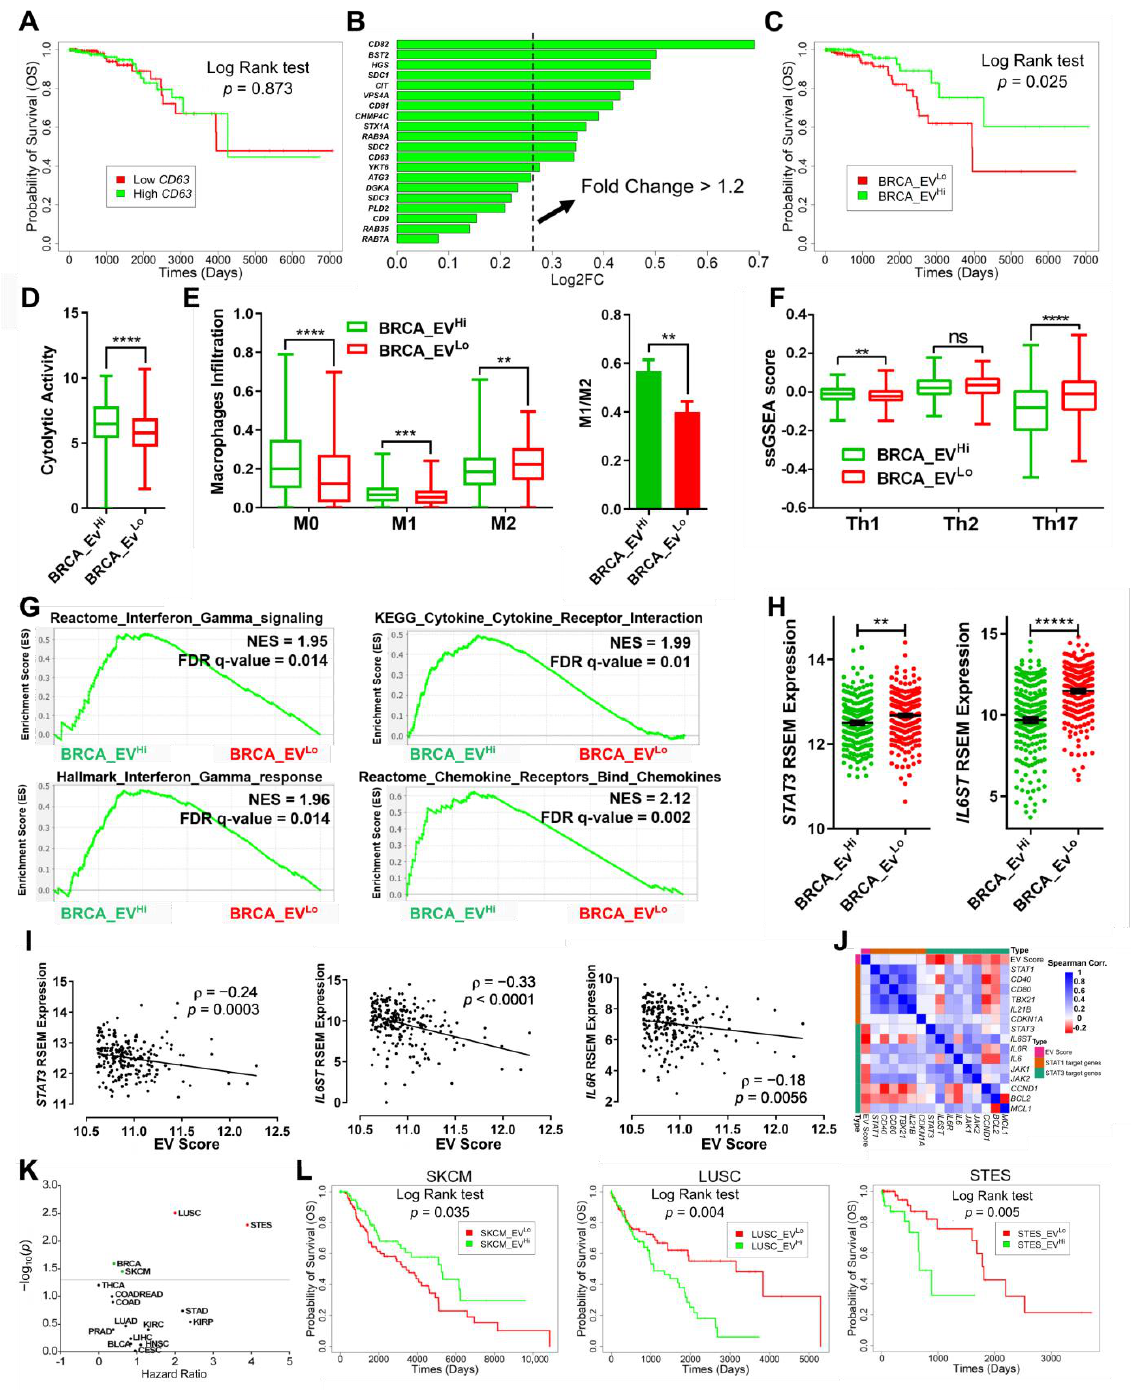
Figure 5. Increased EV secretion is correlated with better survival in non-metastatic breast cancer patients. ( A ) The overall survival of non-metastatic breast cancer patients (N0 and M0 in TNM staging system) divided by the median of CD63 expression. ( B ) Enrichment of the genes associated with CD81 + CD63 + EVs secretion in the BRCA_EV Hi patients. The 13 genes with fold change > 1.2 were selected as the CD81 + CD63 + EV gene signature. ( C ) Differences in the survival of non- metastatic breast cancer patients stratified by the median expression of CD81 + CD63 + EV gene signature. ( D ) Cytolytic activity score of non-metastatic breast tumors comparing the BRCA_EV Hi and BRCA_EV Lo patients (mean ± SEM). **** p < 0.01. ( E ) Macrophage infiltration scores and ratio of M1/M2 macrophages for the BRCA_EV Hi and BRCA_EV Lo tumors deter- mined by CIBERSORTx (mean ± SEM). ** p < 0.01, *** p < 0.001, **** p < 0.0001. ( F ) The immune score of T helper cells